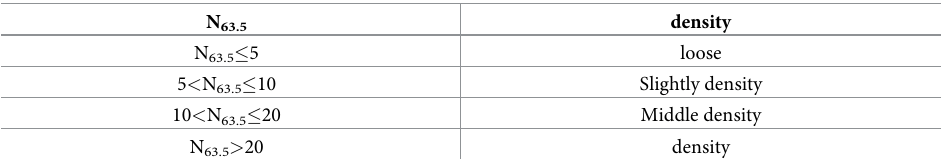
Table 6. The density of crushed stone